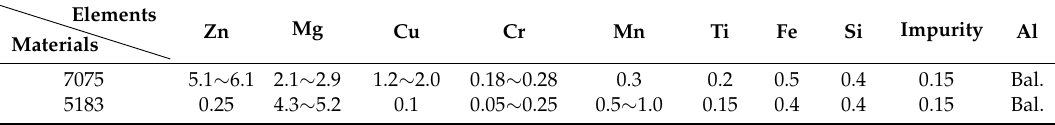
Table 1. Chemical compositions of 7075 aluminum alloy and ER5183 welding wire (wt-%).